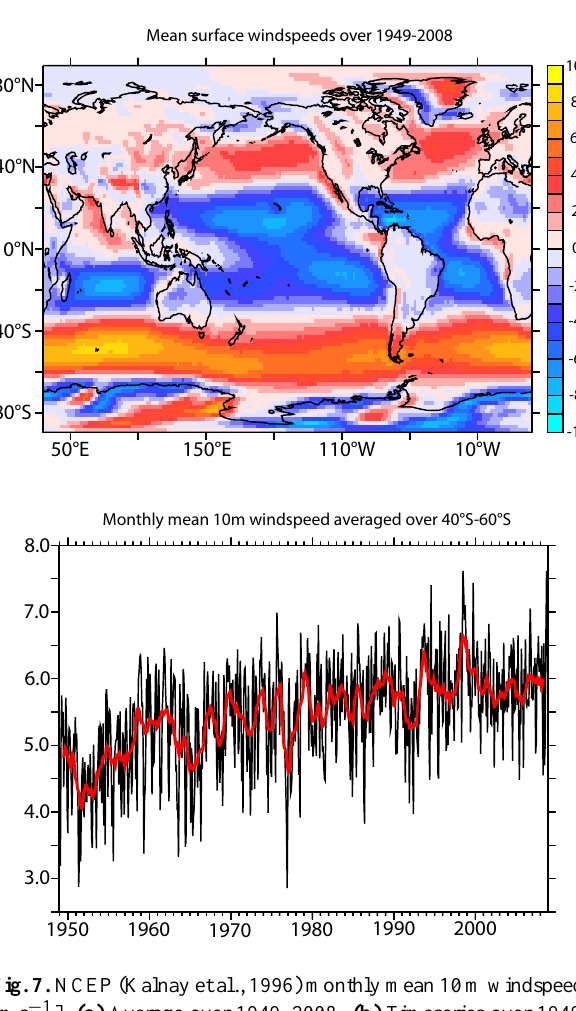
Fig. 7. NCEP (Kalnay et al., 1996) monthly mean 10m windspeeds [ms − 1 ]. (a) Average over 1949–2008. (b) Timeseries over 1949– 2008 of monthly mean values averaged over 40 ◦ S–60 ◦